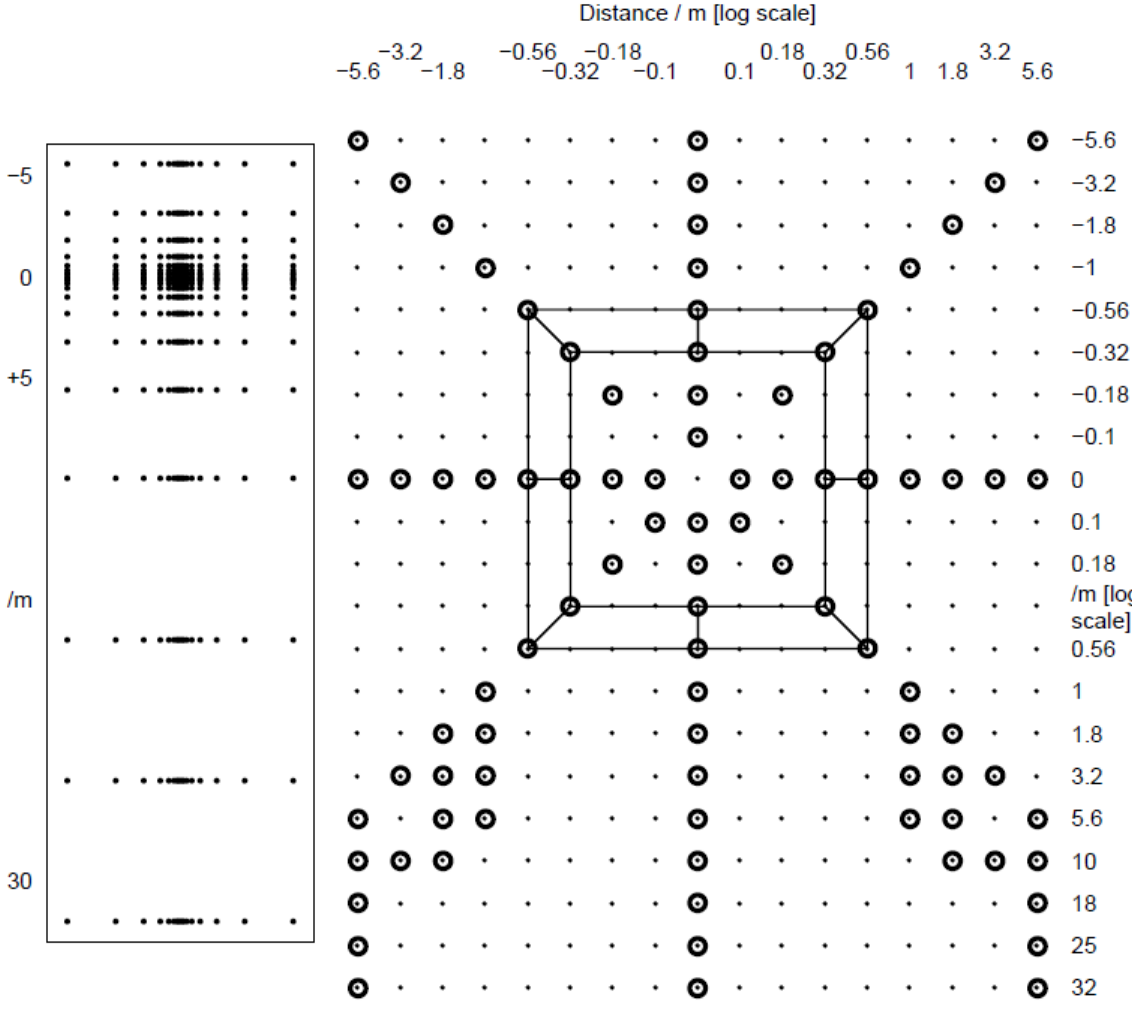
Figure 4. Sampling grid, aspect ratio 1:1. Left: potential grid, true scale. Right: 88 actual sampling positions, log scale (to show detail). The 4 th of 8 shells around the injection site is outlined. It comprises 8 trapezoidal segments. There are 4 extra pairs of rectangles at the bottom of the